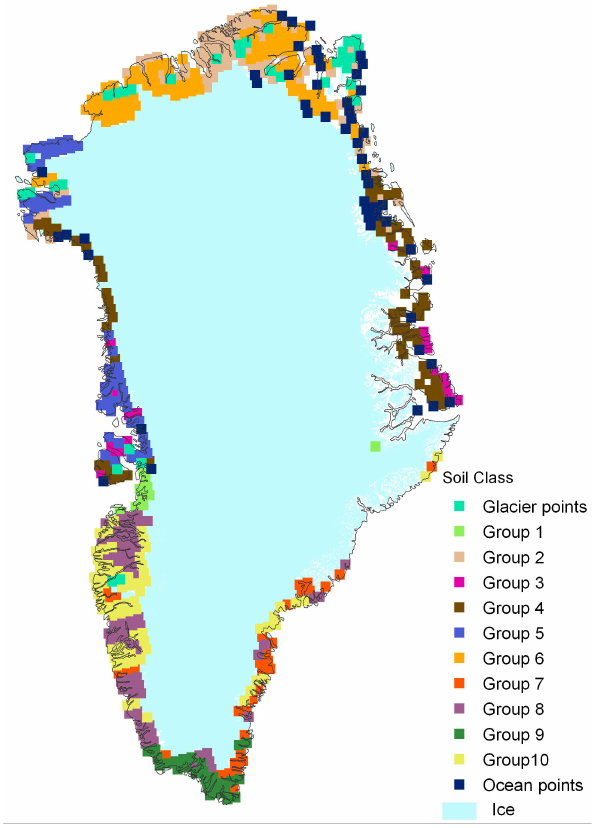
Fig. 1. Soil classification zones, based on soil orders from the Food and Agriculture Organization of the United Nations